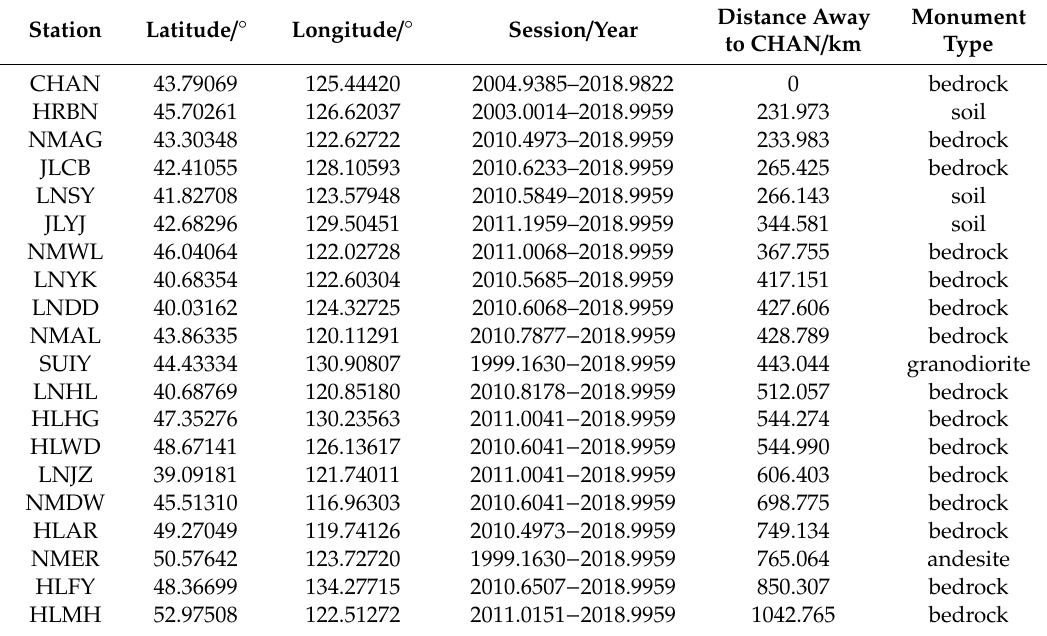
Figure 4. Distribution of IGS and CMONOC stations in Northeast Block of China. Table 3. Introduction of IGS station (CHAN) and CMONOC stations in Northeast Block of China.